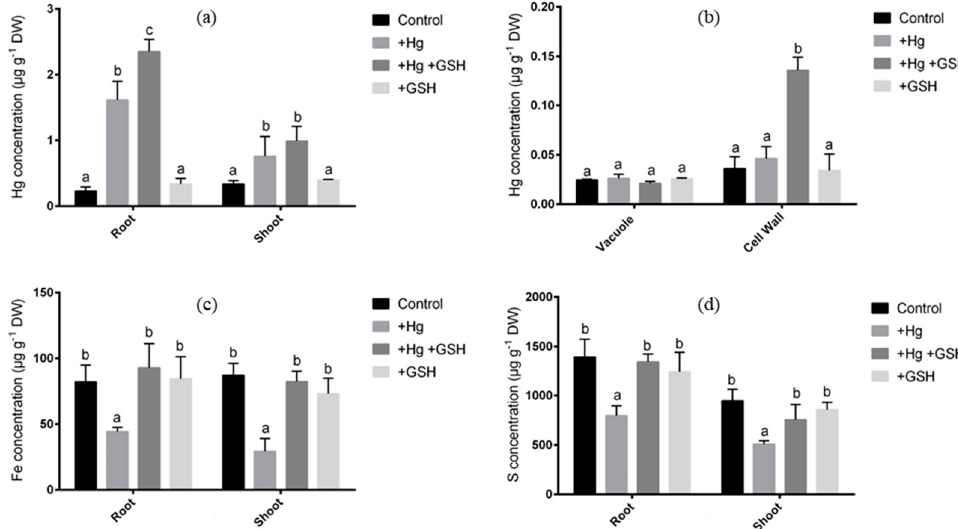
Figure 4. Elemental concentration in root shoot, vacuole, and cell wall of alfalfa. Concentration of Hg ( a , b ), Fe ( c ) and S ( d ) in alfalfa cultivated in di ff erent conditions of Hg and GSH: + Hg (40 µ M), + Hg + GSH (40 µ M Hg + 50 µ M GSH), and + GSH (50 µ M GSH). Data represent means ± SD of three independent biological samples. Di ff erent letters indicate a significant di ff erence at the p < 0.05